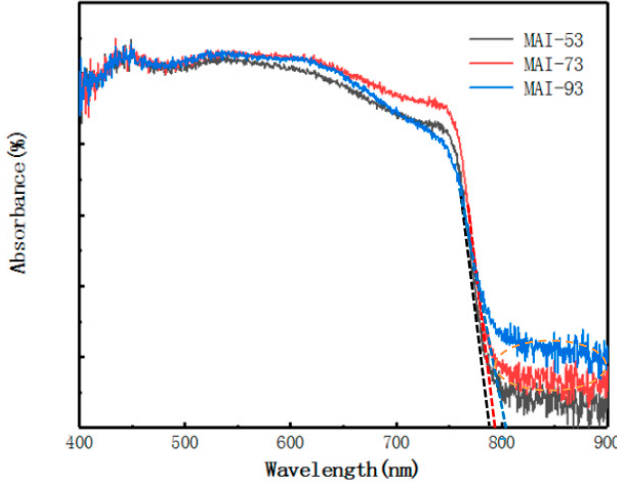
Figure 8. UV–Vis spectra of organic–inorganic hybrid perovskite films with different concentrations of MAI precursor solution. Table 1. The Urbach energy and steepness parameters of absorption data.